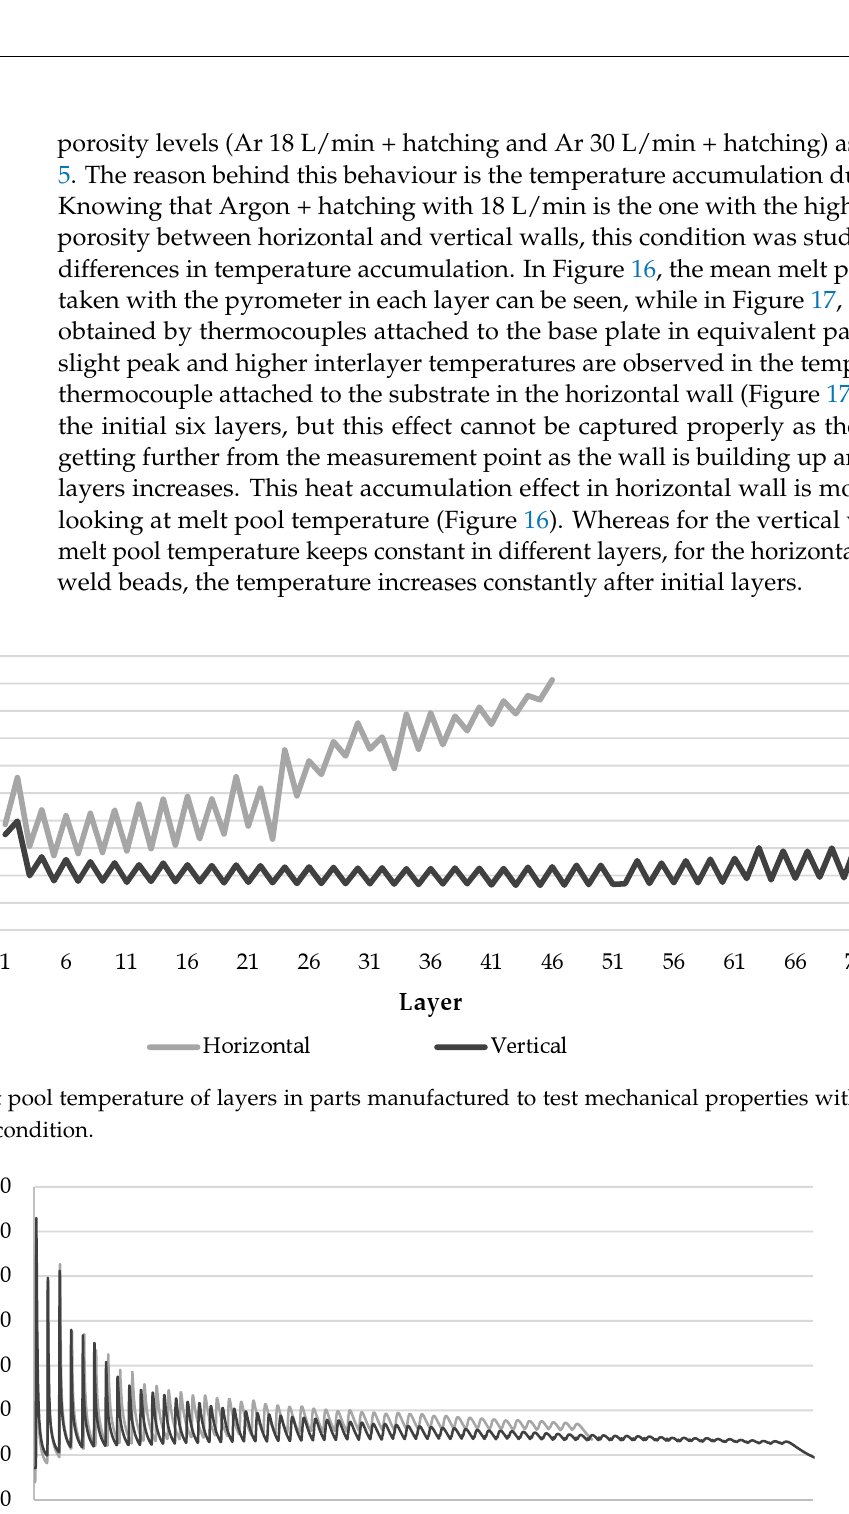
Figure 15. Porosity histogram of WAAM walls manufactured for testing of mechanical properties. Naming sequence: Shielding gas_Deposition strategy_Gas flow rate_Specimen testing direction.